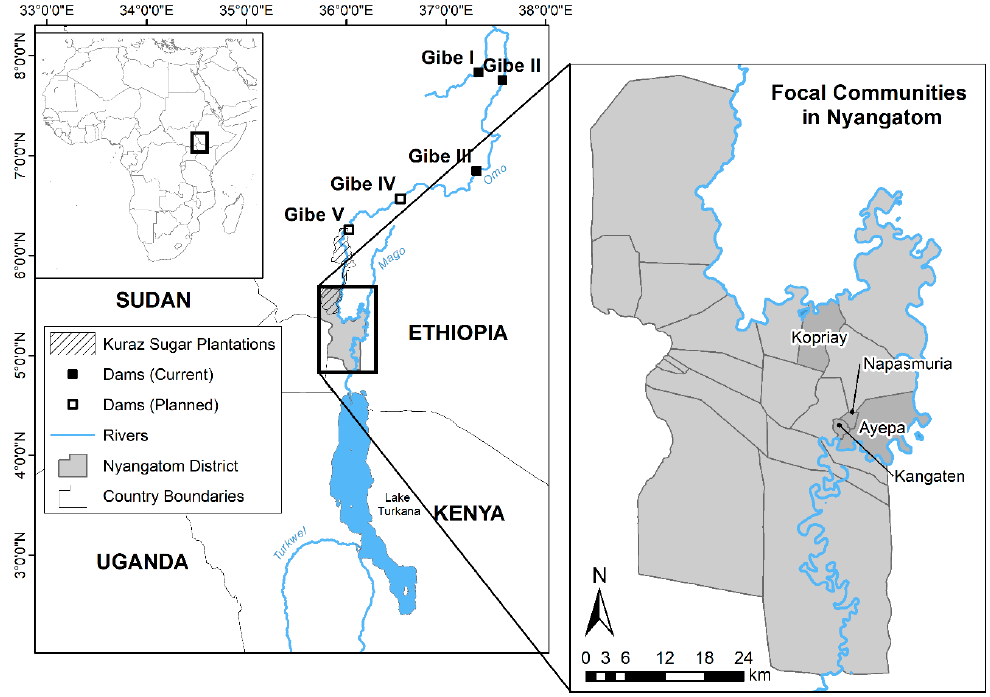
Figure 1. The study site—Nyangatom woreda, Ethiopia.